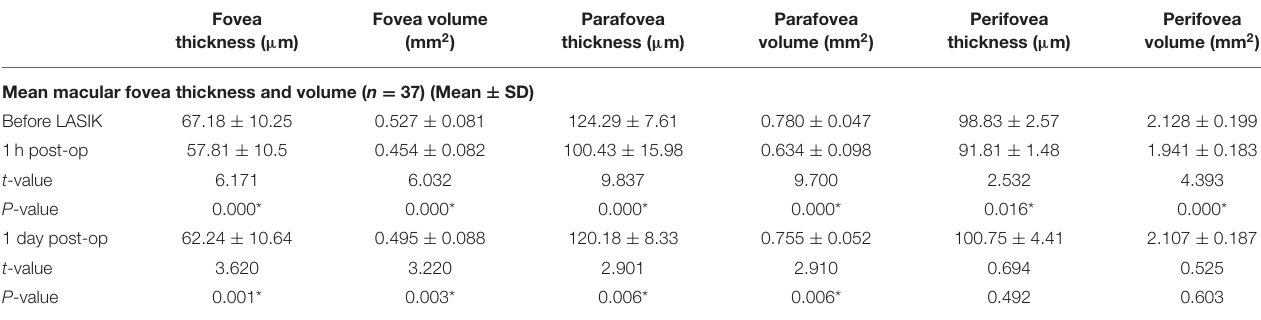
TABLE 1 | Mean macular fovea thickness and volume before and after femtosecond laser laser-assisted in situ keratomileusis (FS-LASIK) surgery. Fovea thickness ( µ m)